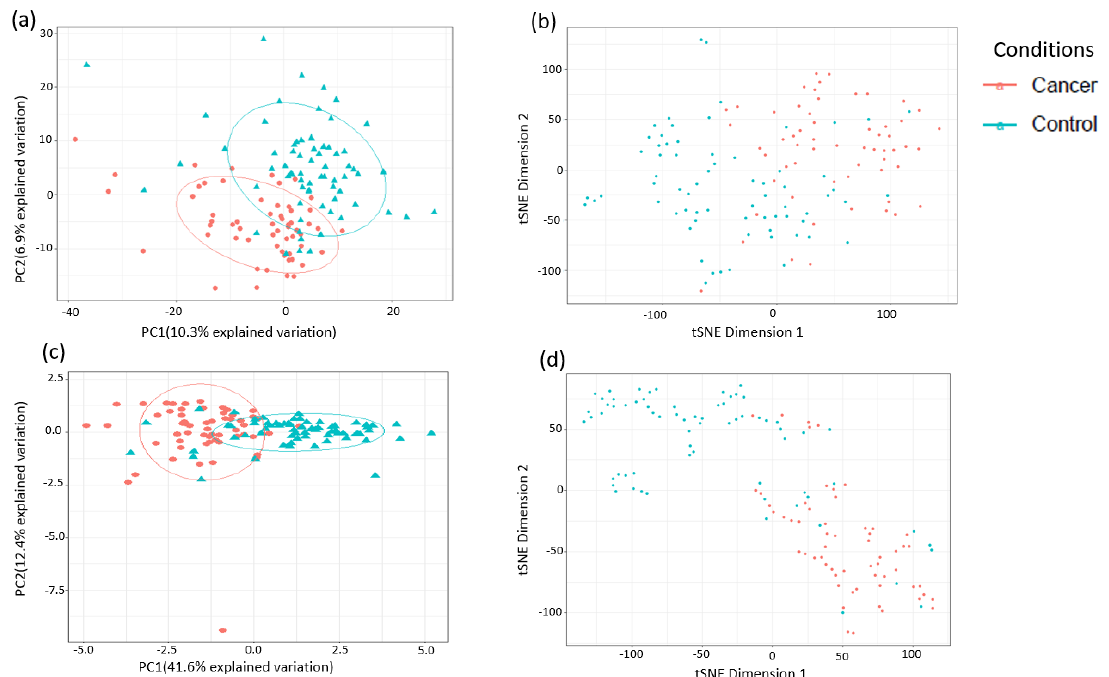
Figure 6. Analysis of sample separation (comparing early-stage (stage 1) endometrial cancer versus controls ( n = 102, cancers = 47, controls = 55) based on PCA ( a , c ) and t-distributed stochastic neighbour embedding (t-SNE) ( b , d ) analyses using all identified metabolites ( a , b ) and the top 10 discriminatory metabolites ( c , d ) identified by random forest machine learning technique. t-SNE (perplexity: 5, iteration: 10000).